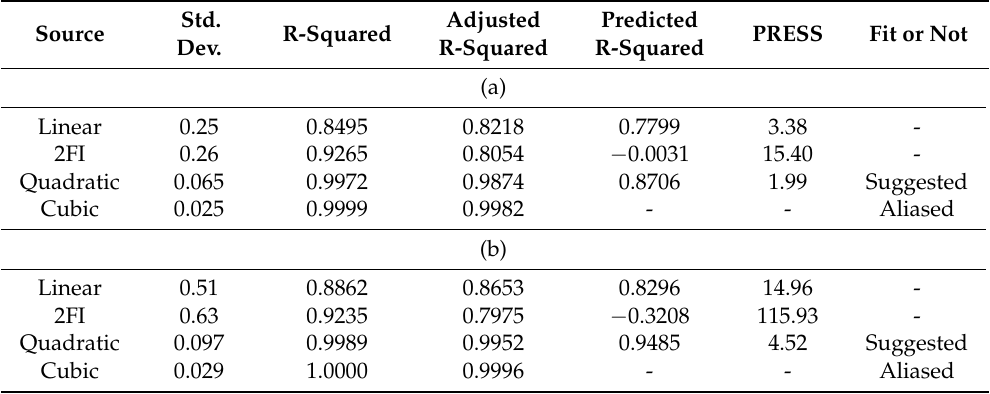
Table 4. (a) Statistics approach to select the RSM model for short-term production. (b) Statistics approach to select the RSM model for long-term